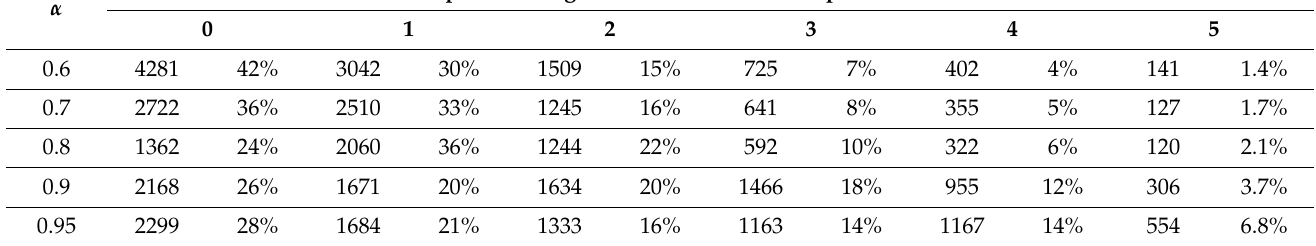
Table 1. Distribution of the number of search algorithm runs for which no improvement of the cost function was